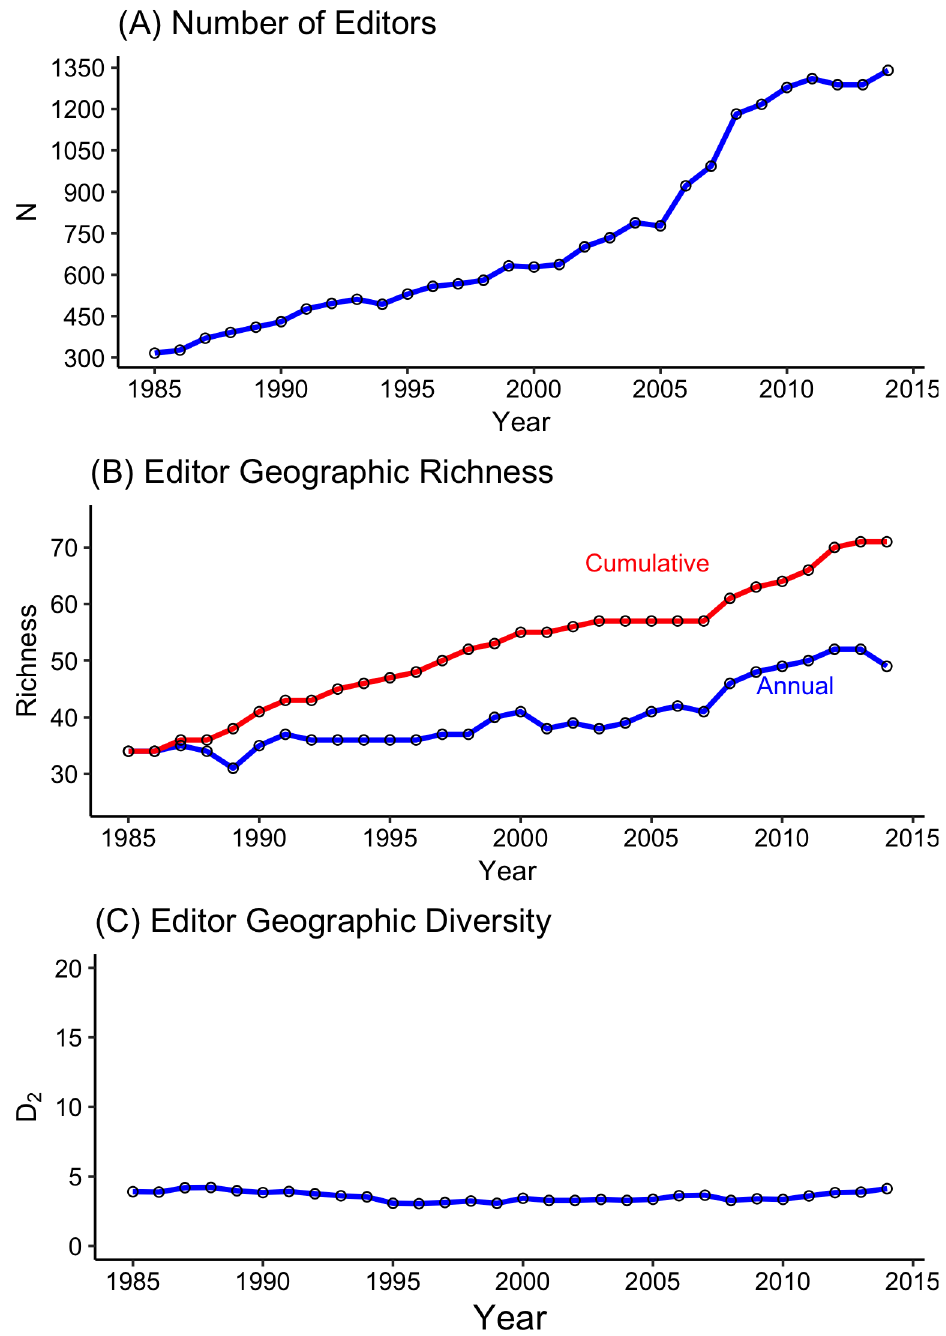
Fig 1. Community composition of editors in environmental biology (1985–2014). (A) Geographic richness: cumulative richness is the total numberof countriesrepresentedby at least one editor through a given year; annualrichness is the total number of countries represented by editors in each year. (B) The total numberof uniqueeditors servingeach year from 1985 to 2014. (C) The geographicdiversity of editors in environmental biologyeach year from 1985 to 2014. We measureddiversity using the reciprocal of D 2 . Larger values of D 2 indicategreater diversity, with the MPD equalto the greatest numberof countries representedin any 1 year of the survey (MPD editors = 52). For additionaldetails, see S1 Text. The DOIs for the datasets used in this paper (both archivedat Dryad) are https://doi.org/10.5061/dryad.6jn86.2 and https://doi.org/10. 5061/dryad.mh189. D 2 , Simpson’sindex; MPD, maximum potential